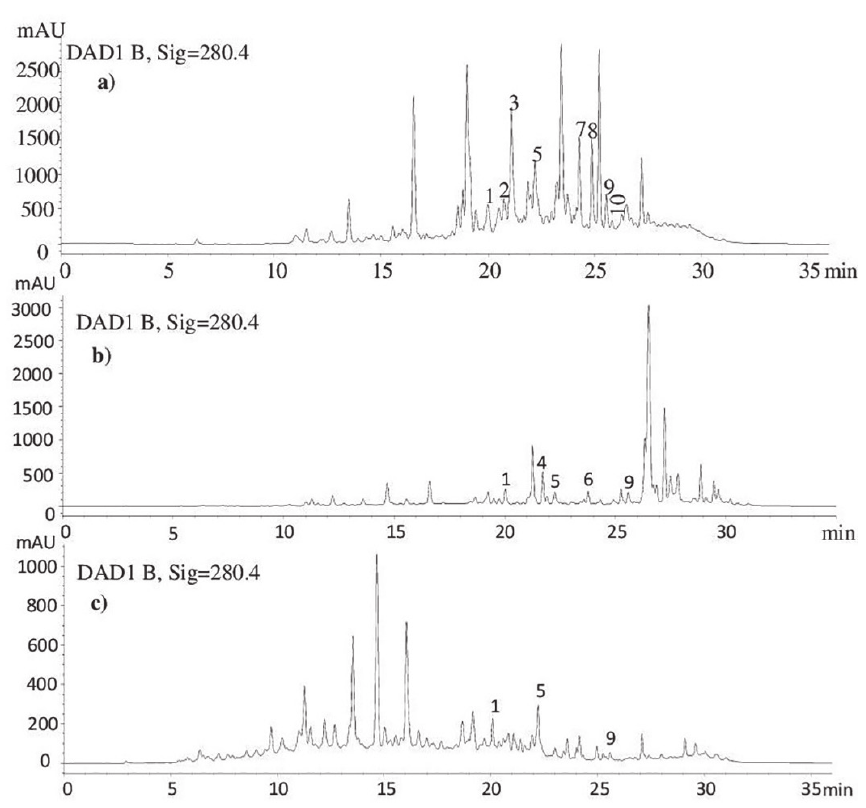
Quantity (mg g -1 of residue ) Retention time (min) AF.Pn ME.Pn ME. Pa